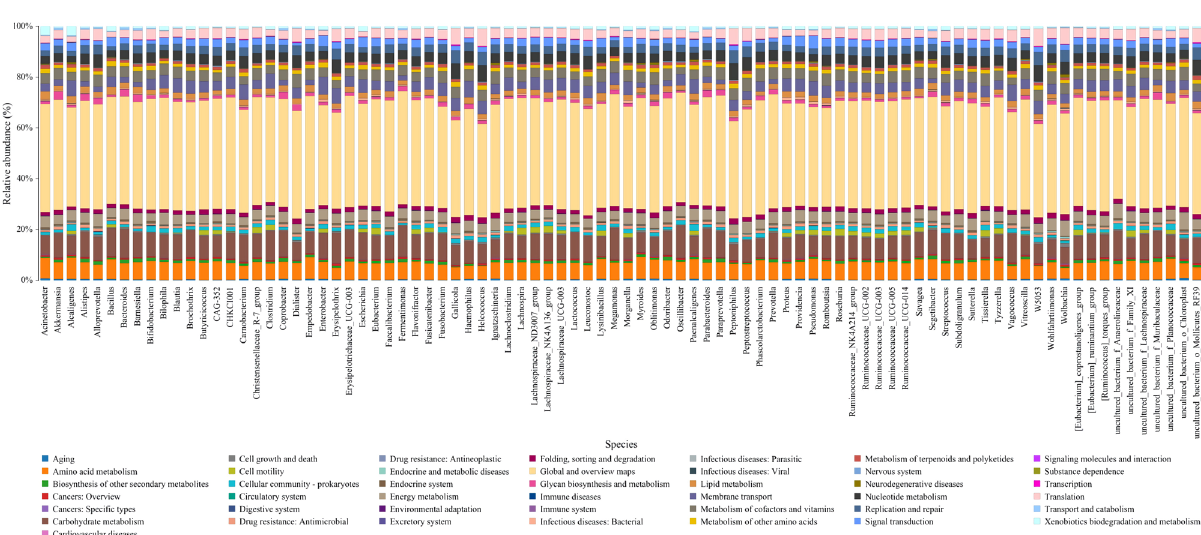
Figure 6. KEGG functional secondary classification at the genus level. The X-axis indicates the species, and the Y-axis shows the relative abundance percentage of metabolic